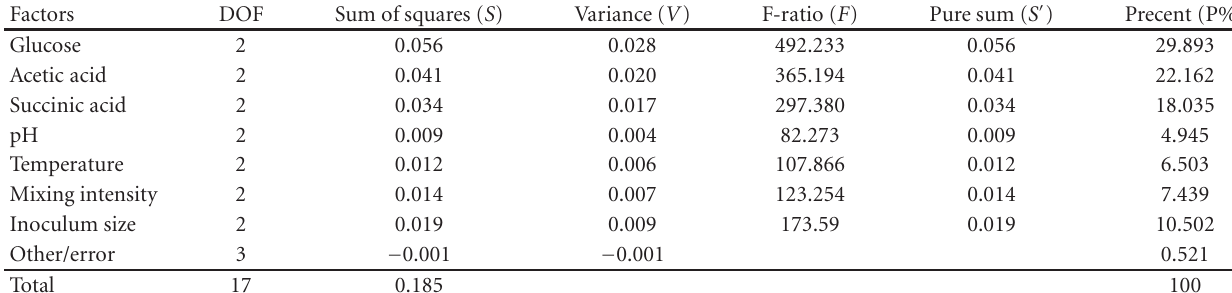
Table 5: Analysis of variance (ANOVA).